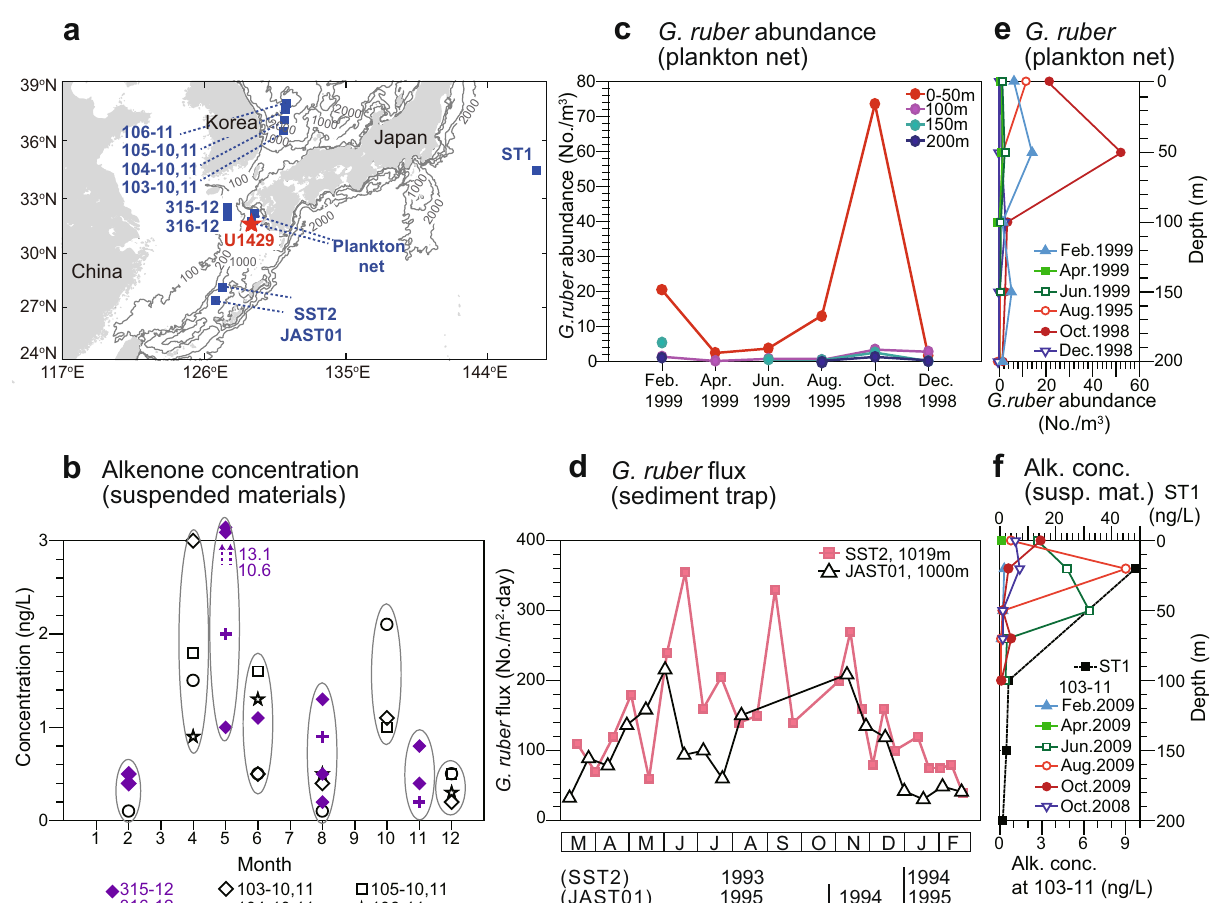
Fig. 3 Seasonal and vertical variations of Globigerinoides ruber and alkenone producers. a Location of sampling sites in the East China Sea and nearby. b Variation in the alkenone concentration of suspended particles 32, 33 . c Variations in the abundance of G. ruber based on plankton net sampling in the East China Sea 28 . d Variations in the fl ux of G. ruber based on sediment trap records for the Okinawa Trough 26,27 . Vertical distributions of the abundance of e G. ruber 28 and f total C 37 alkenone concentration in the northwest Paci fi c 32, 34